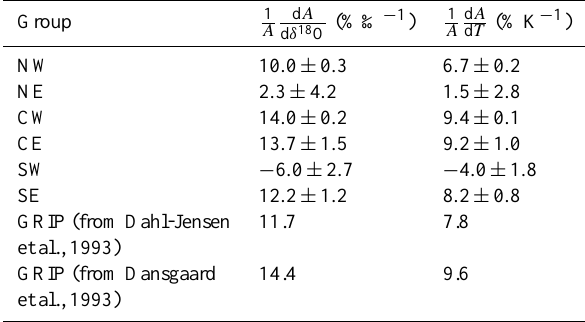
Table 2. The sensitivity of accumulation rate A to changes in δ 18 O and temperature T . Accumulation rate-isotope sensitivities are re- flected in the value of C 1 in the equation form of A = 0 . 23 × ture dependence uses the linear δ 18 O- T relationship described in Eq. (2). The given uncertainties are derived from the uncertainty in the least squares estimation of the parameters in Eqs. (3)–(8) and do not represent the total uncertainty which is